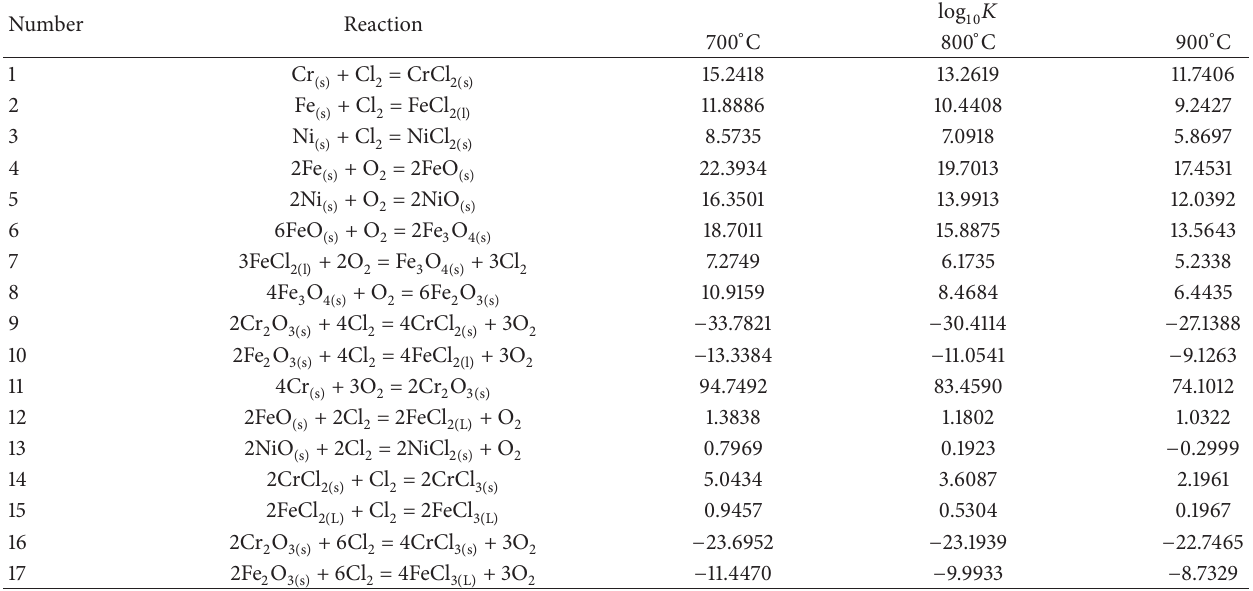
Table 2: Chemical reactions and equilibrium constants for the Fe-Cr-Ni-Cl-O